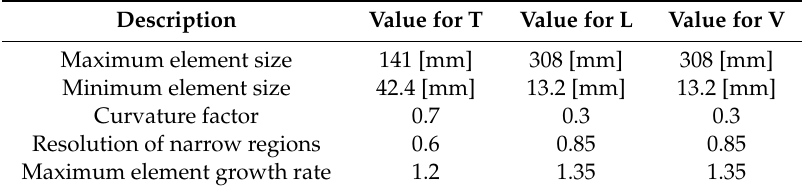
Table 2. Mesh settings for the tunnel (T), the lamp (L), and its vicinity (V).